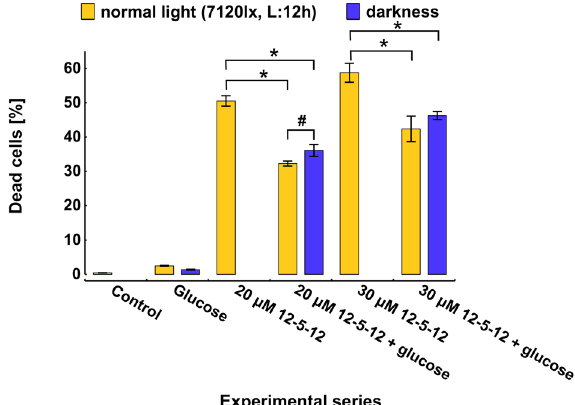
Figure 8. The effect of glucose and darkness on cell viability during 72-h exposition to various concentrations of the 12-5-12 surfactant. The columns show mean values and the error bars represent standard deviation from three independent treatments. L refers to light, lx refers to lux. Statistical significance was assessed with the Student’s t test. An asterisk and a number sign indicate statistically significant differences (p < 0.001 and p = 0.03